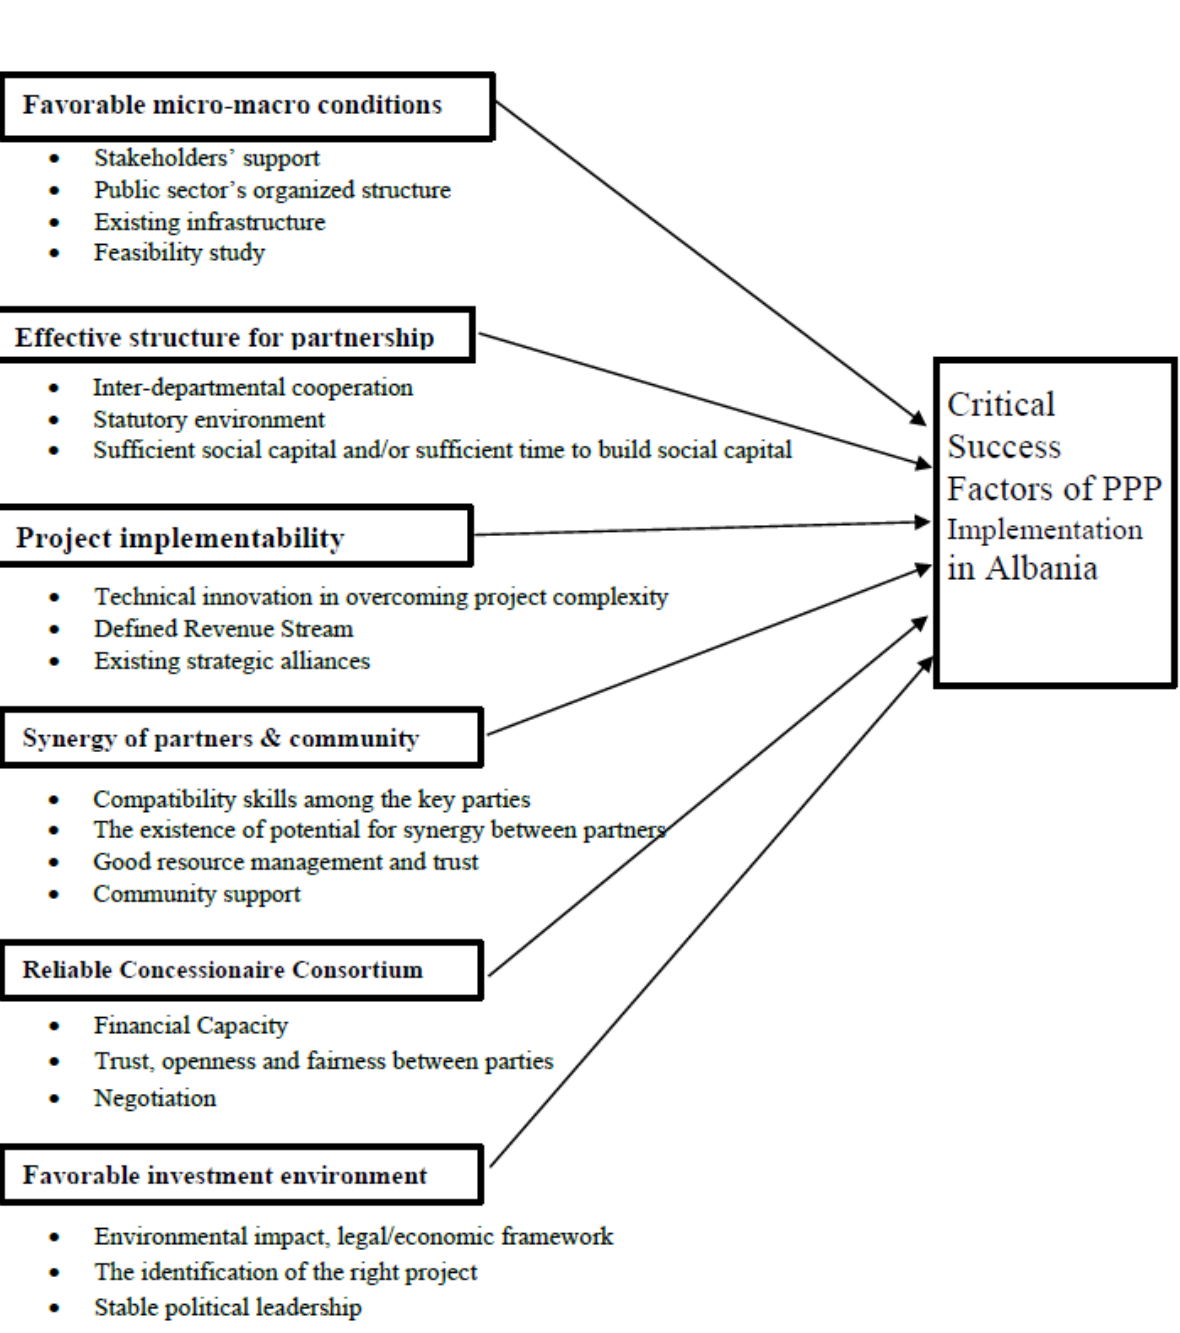
Figure 1. Research model of the study.